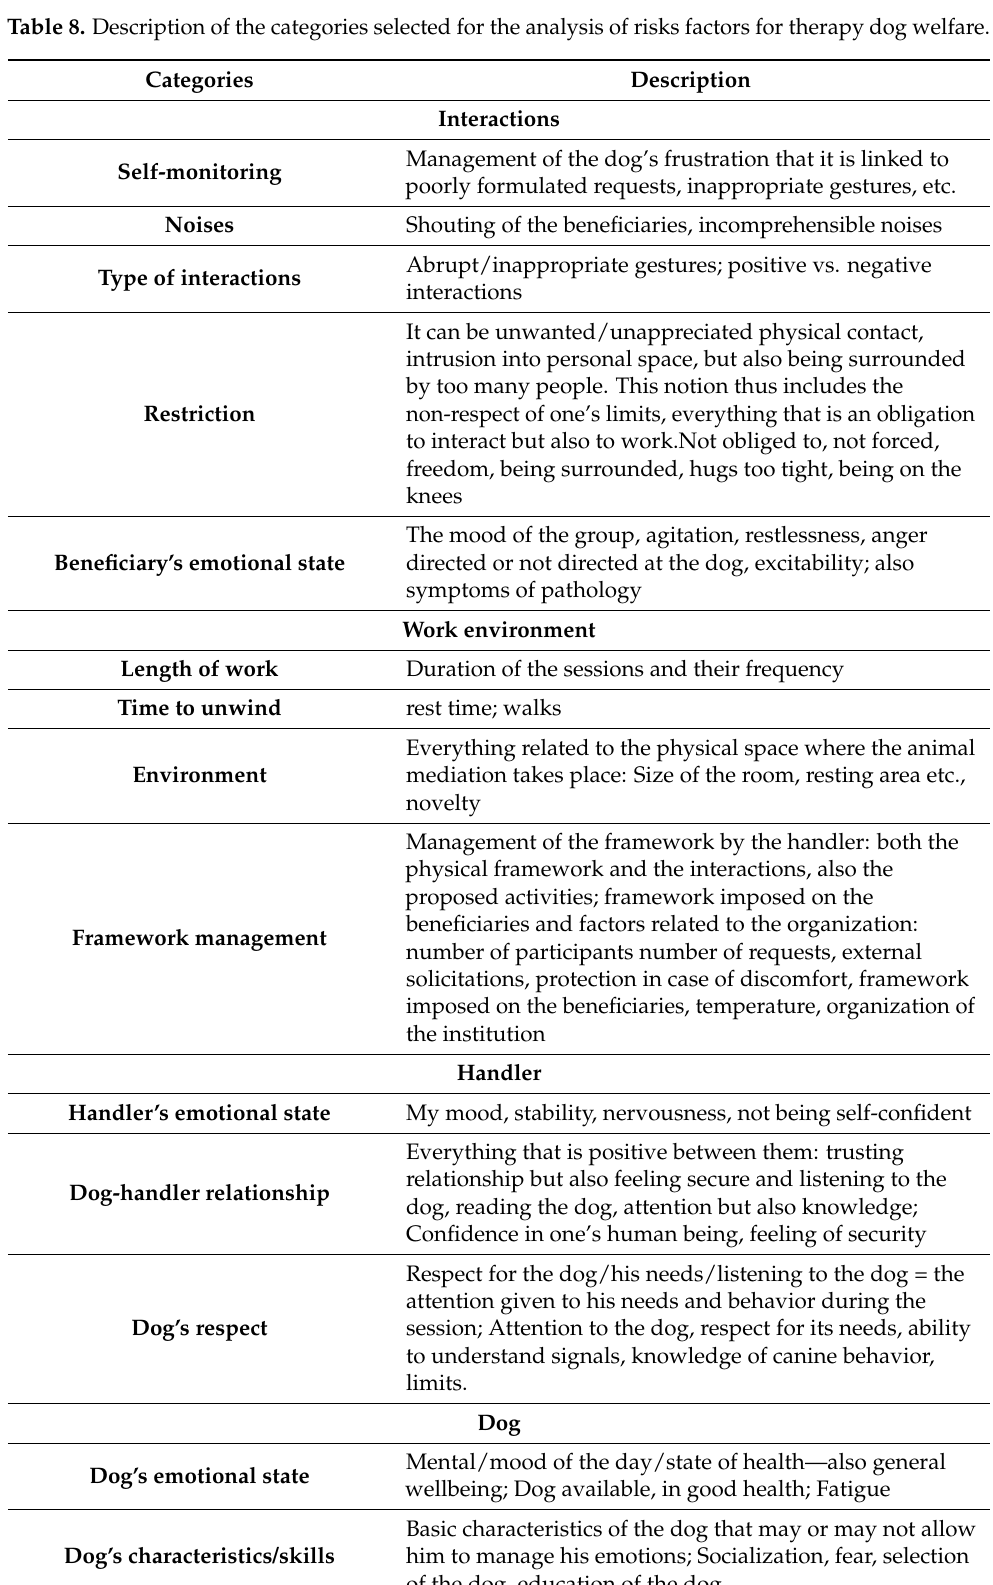
Table 8. Description of the categories selected for the analysis of risks factors for therapy dog